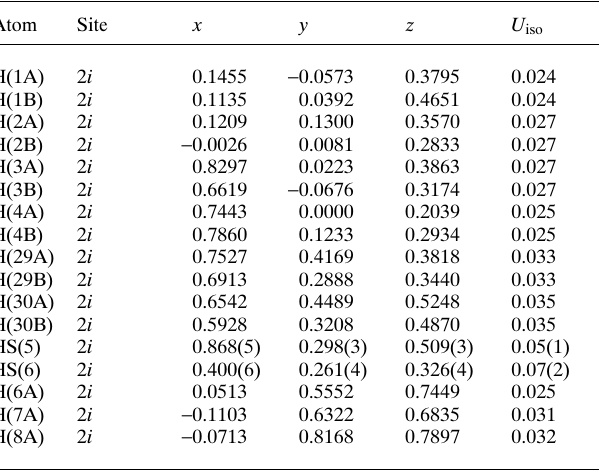
Table 2. Atomic coordinates and displacement parameters (in Å 2 )